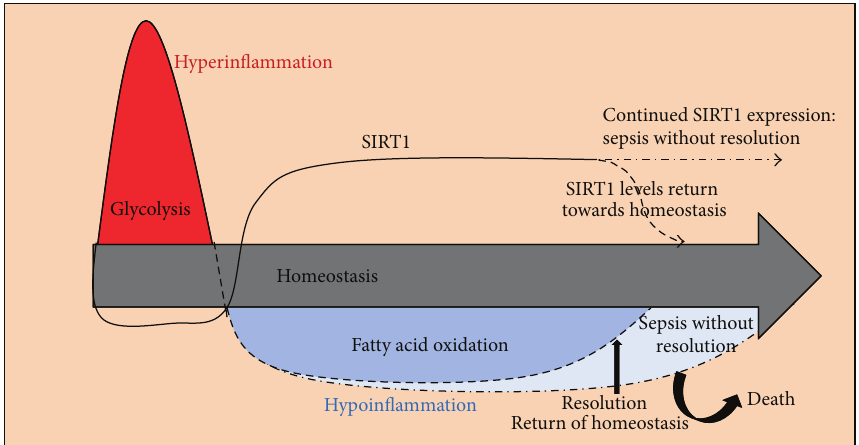
Figure 2: Sirtuins and acute inflammation of sepsis: the extreme stress response of sepsis rapidly induces a systemic and potentially lethal hyperinflammatory state (red), which shifts within hours to a counterreactive hypoinflammation/adaptation phase (blue). NAD+ activation of sirtuins directs this switch. Mechanistically, nuclear SIRT1 levels briefly drop when homeostasis deviation initiates the glycolysis- dependent hyperinflammation, but within hours nuclear and mitochondrial sirtuin activation shifts glycolysis to fatty acid oxidation. This metabolic reprogramming globally represses immunity, affecting neutrophils, monocytes, dendritic cells, NK cells, and T lymphocytes. Resolution of acute inflammation and sepsis rebalances sirtuins and inflammation to restore homeostasis. Persistent elevation of sirtuins and hypoinflammation as a result lead to death (denoted by light blue area).